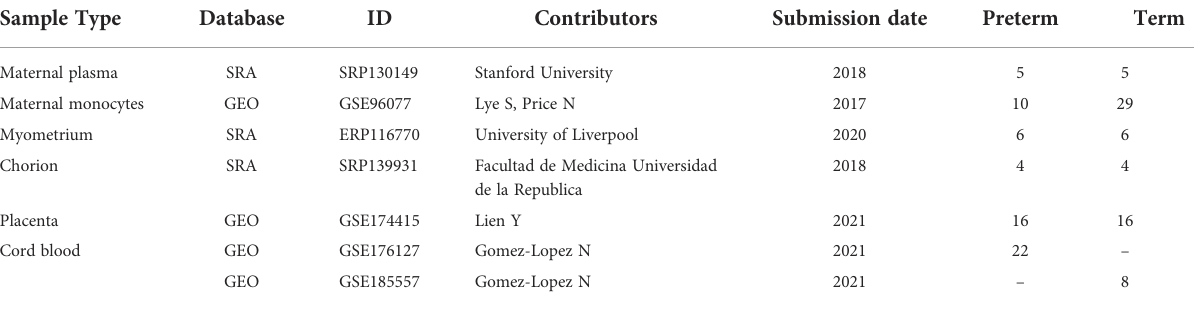
TABLE 1 Summary of the characteristics of all included